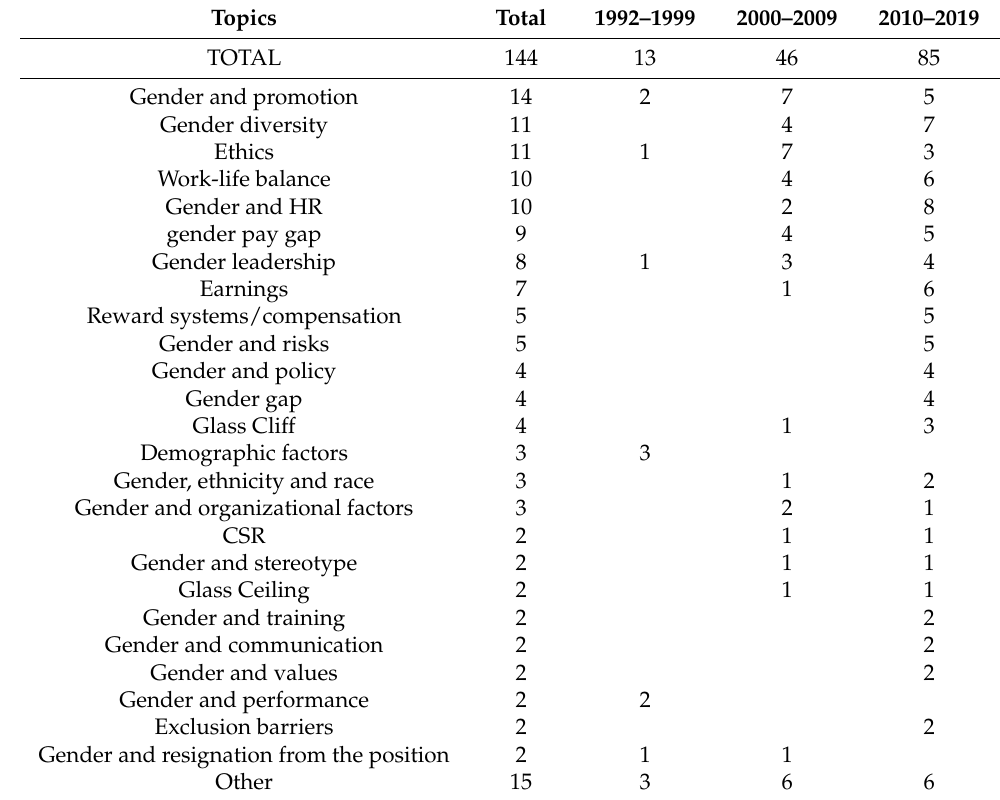
Table 3. Evolution of the relevance of the subjects dealt with in the literature on gender and executives.